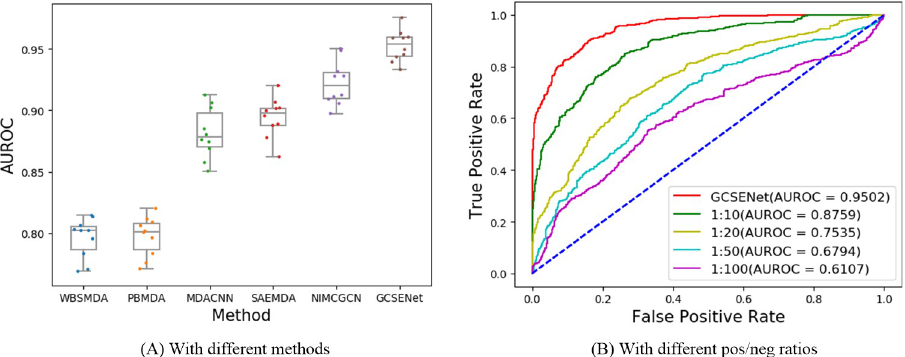
Fig 7. AUROC comparison of miRNA-disease in 10-fold cross-validation. (A) With different methods. (B) With different pos/neg